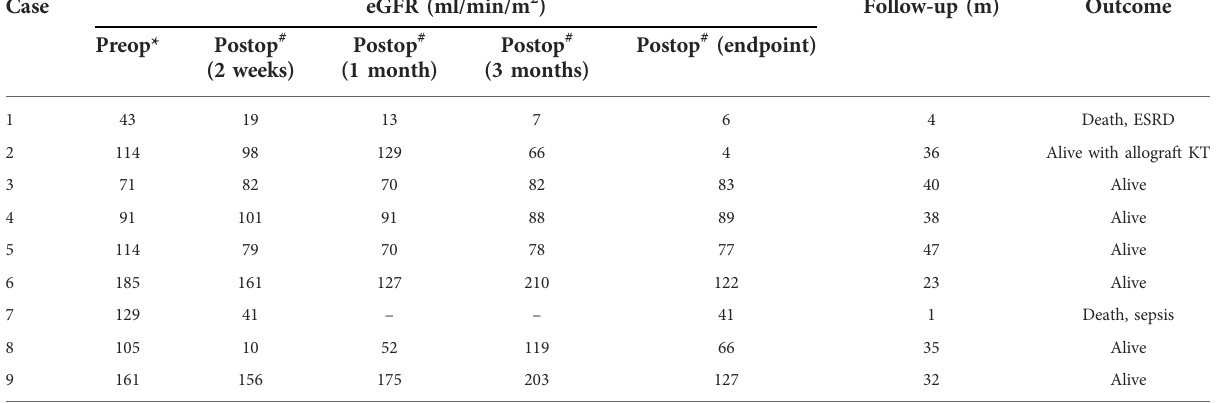
FIGURE 4 Flow chart of surgical strategy.